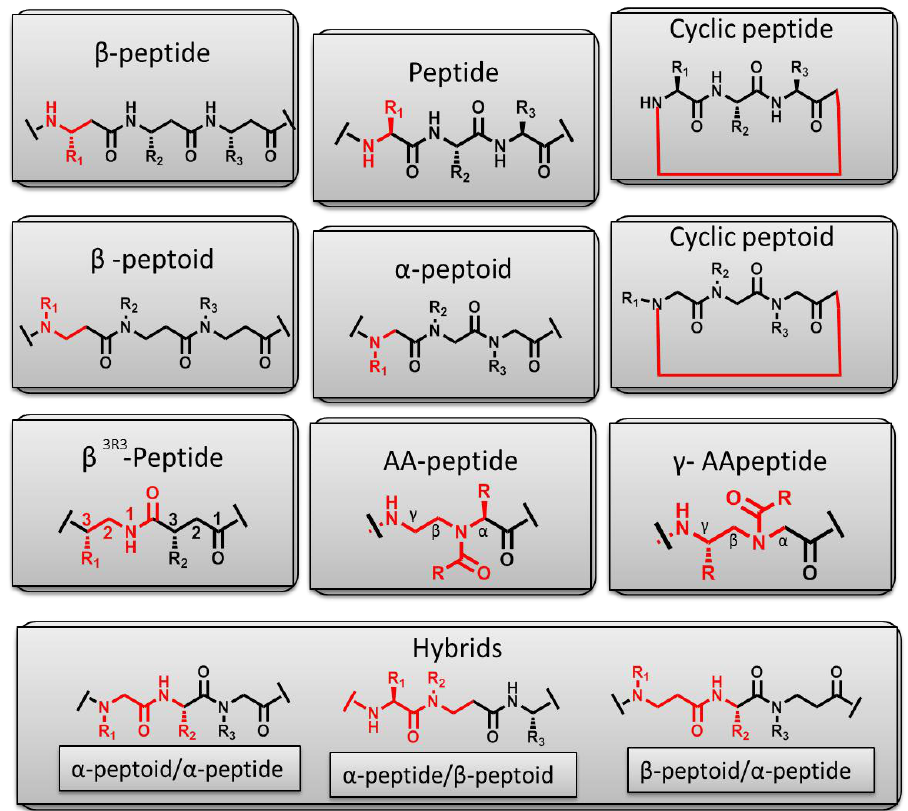
Figure 9. Current peptidomimetic structures with potent antimicrobial activity. The schematic illustrates the different backbone compositions of a variety of peptide and